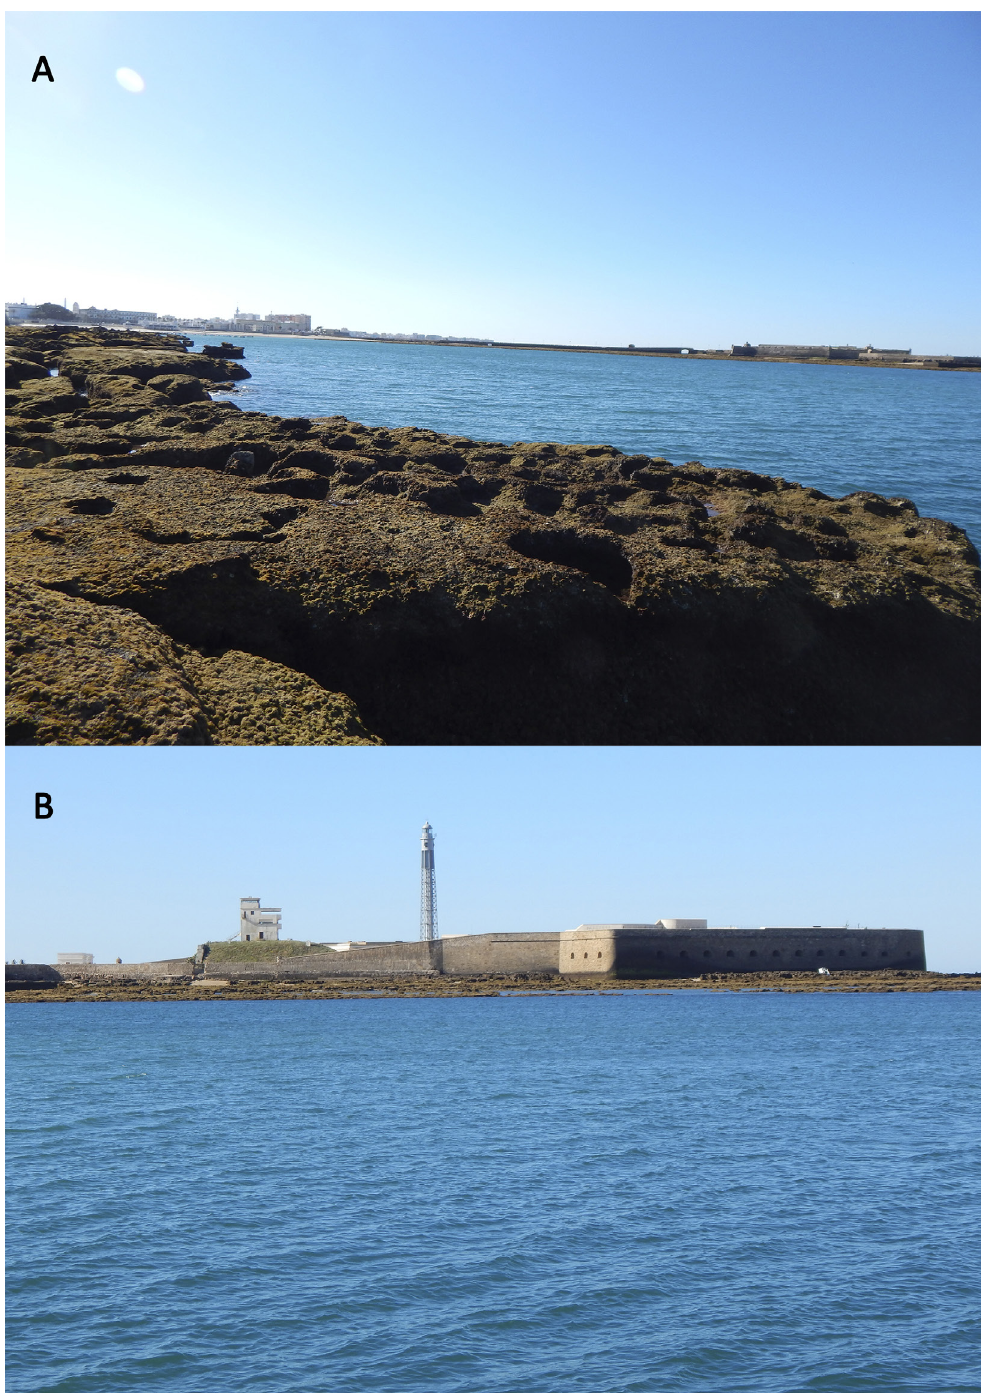
Figure 19. Punta del Nao-point 3. A. Towards the interior of the entrance channel to the La Caleta beach with San Sebastian Castle in the background. B. Detail of San Sebastian Castle.